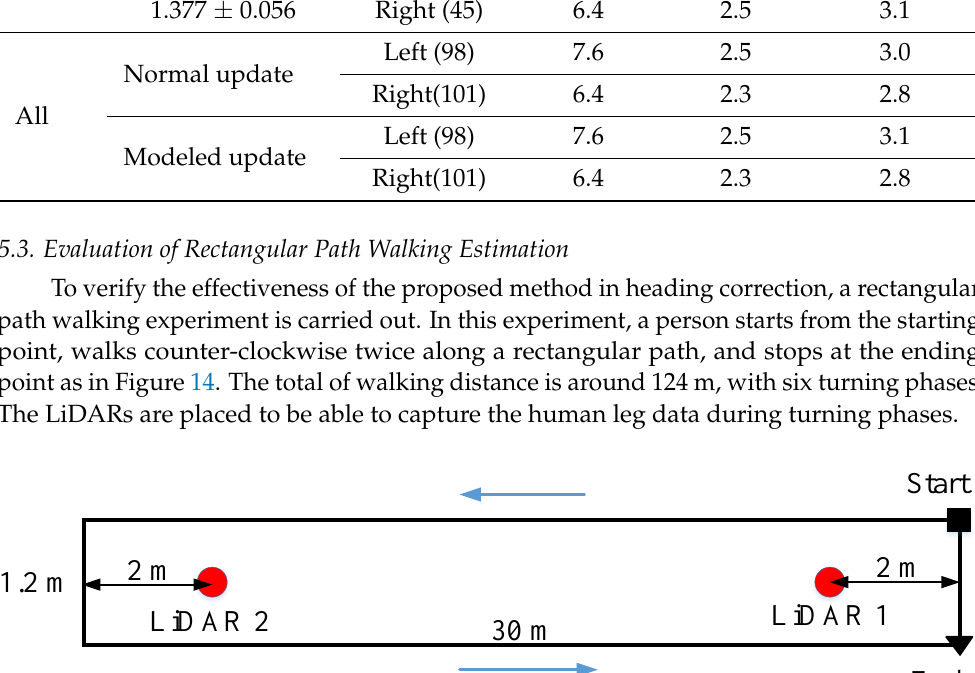
Figure 14. The configuration of rectangular path walk